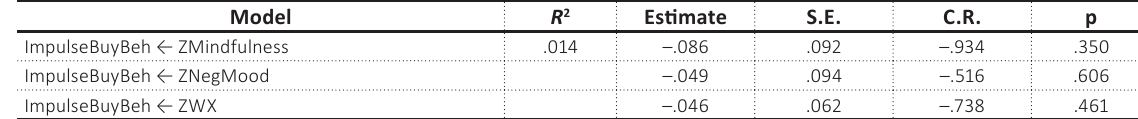
Table 11. The regression weight results of the moderator role of negative